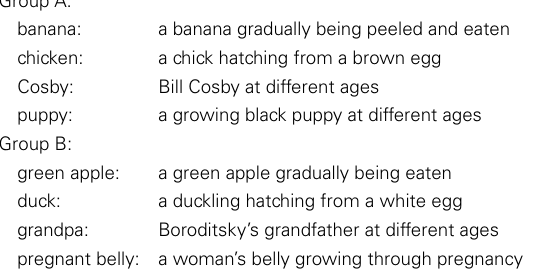
FIGURE 6 |Texts on a China Post vehicle. The Chinese text and the English text CHINA POST on the starboard side of the vehicle (foreground) run in the RL direction, whereas the same texts on the port side